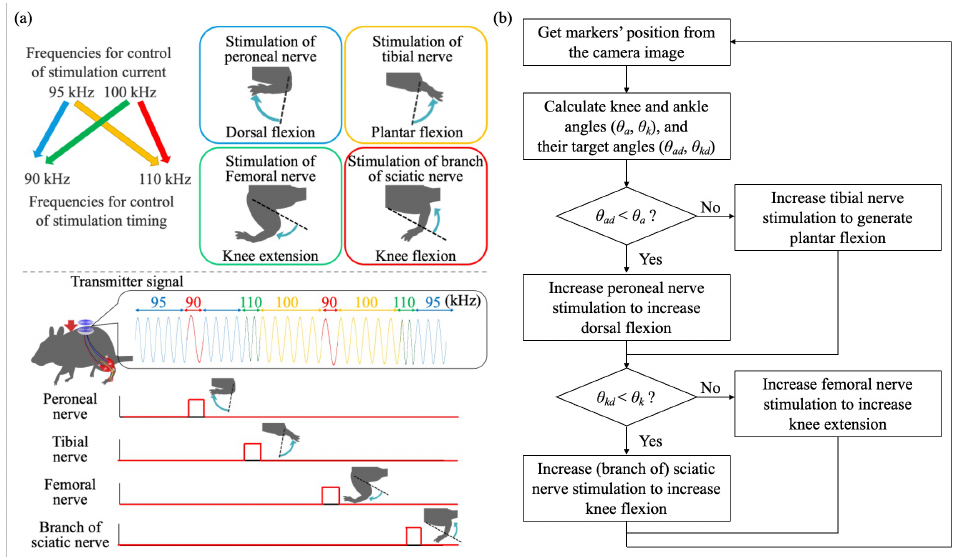
Figure 2. A schematic indicating the selective stimulation of the rat’s four nerves to generate ankle and knee joint motions by switching the frequency of the transmitter signal. ( a ) A schematic of switching the frequency of the transmitter signal to generate four different motions to the rat’s hind leg. ( b ) Flowchart of nerve stimulation for 2 joint